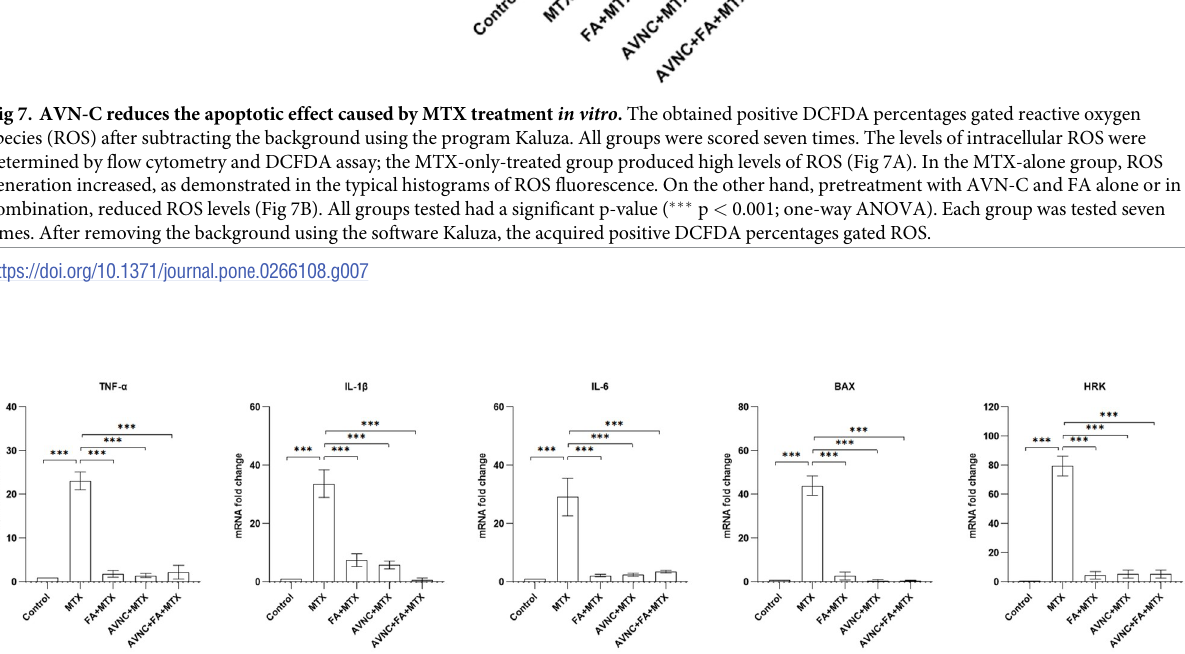
PLOS ONE | https://doi.org/10.1371/journal.pone.0266108 March 30,